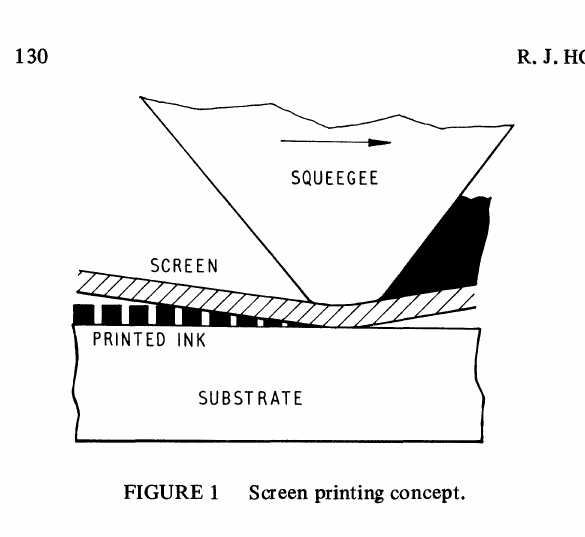
FIGURE Screen printing